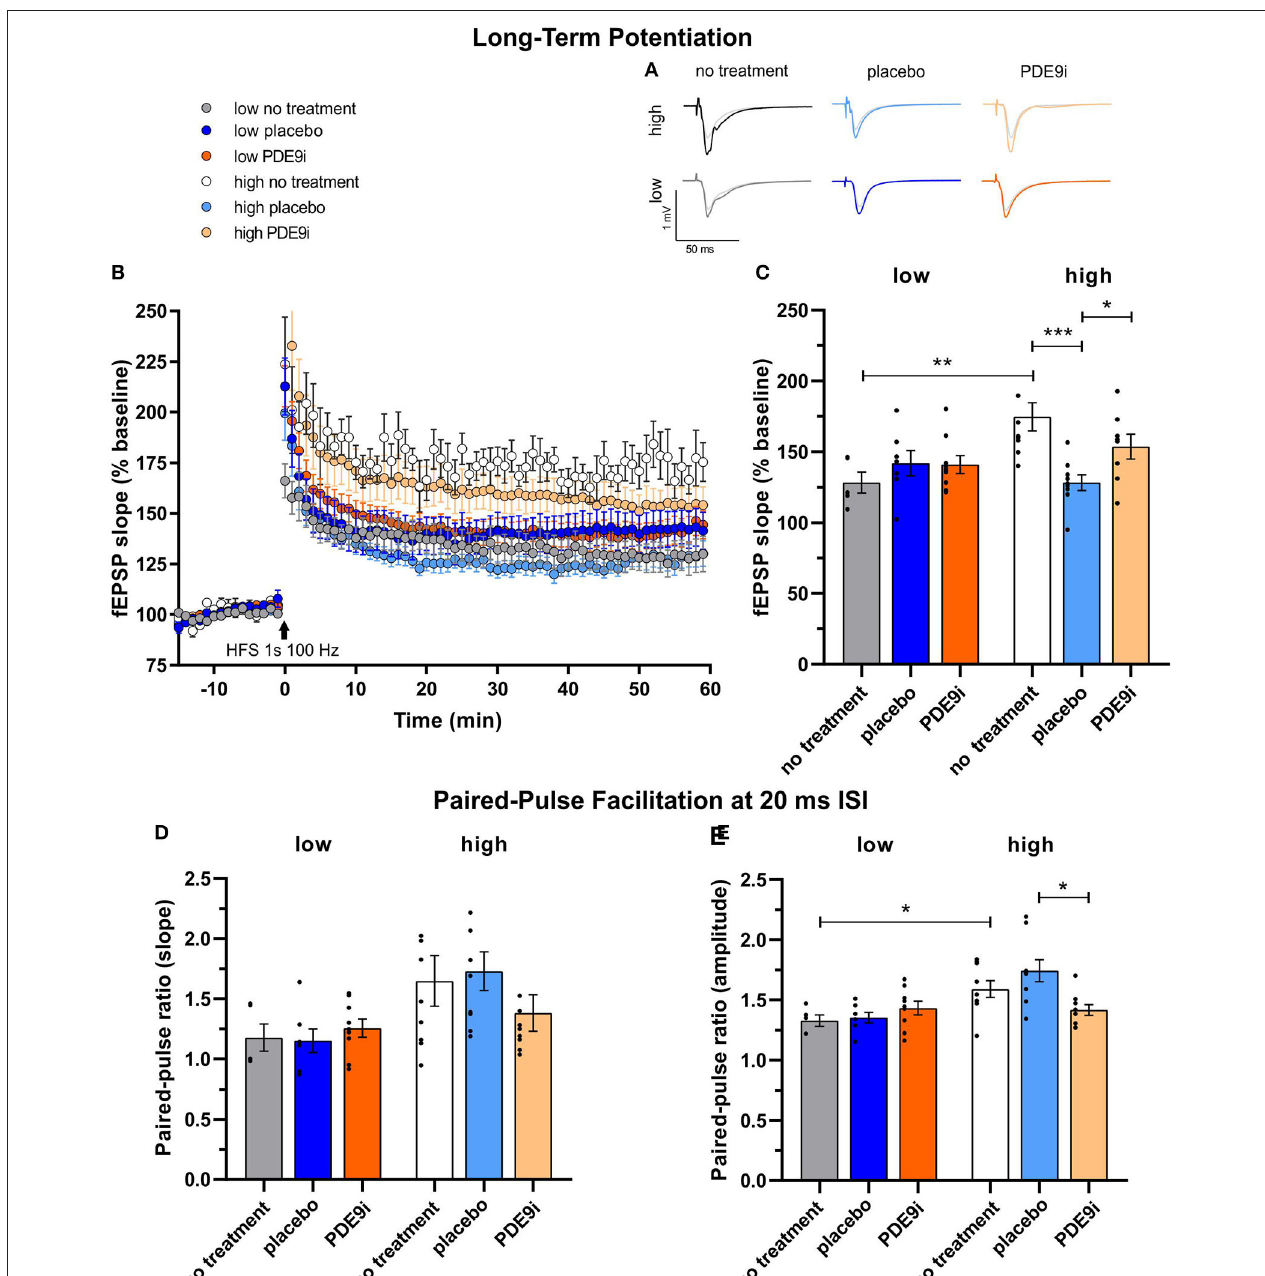
FIGURE 6 | Long-term potentiation (LTP) and paired-pulse facilitation (PPF) of low and high compensators that underwent no treatment, placebo treatment, or PDE9i treatment. (A) Representative traces before and after LTP induction and (B) averaged time courses of fEPSP slopes in acute coronal brain slices displayed prominent LTP in all animal groups. (C) The untreated low compensators had significantly lower LTP in comparison to untreated high compensators. In low compensators, neither a placebo treatment nor PDE9i treatment showed any effect on their already low LTP. In contrast, high compensators treated with a placebo displayed a significantly lower LTP both in comparison to their untreated controls and to high compensators treated with PDE9i. (D) The analysis of the paired-pulse ratio of the fEPSP2/fEPSP1 slope at the 20ms ISI showed no significant differences between high and low compensators before treatment. Neither low compensators nor high compensators treated with either a placebo or PDE9i differed from their untreated controls. Also, no difference in the PPF slope